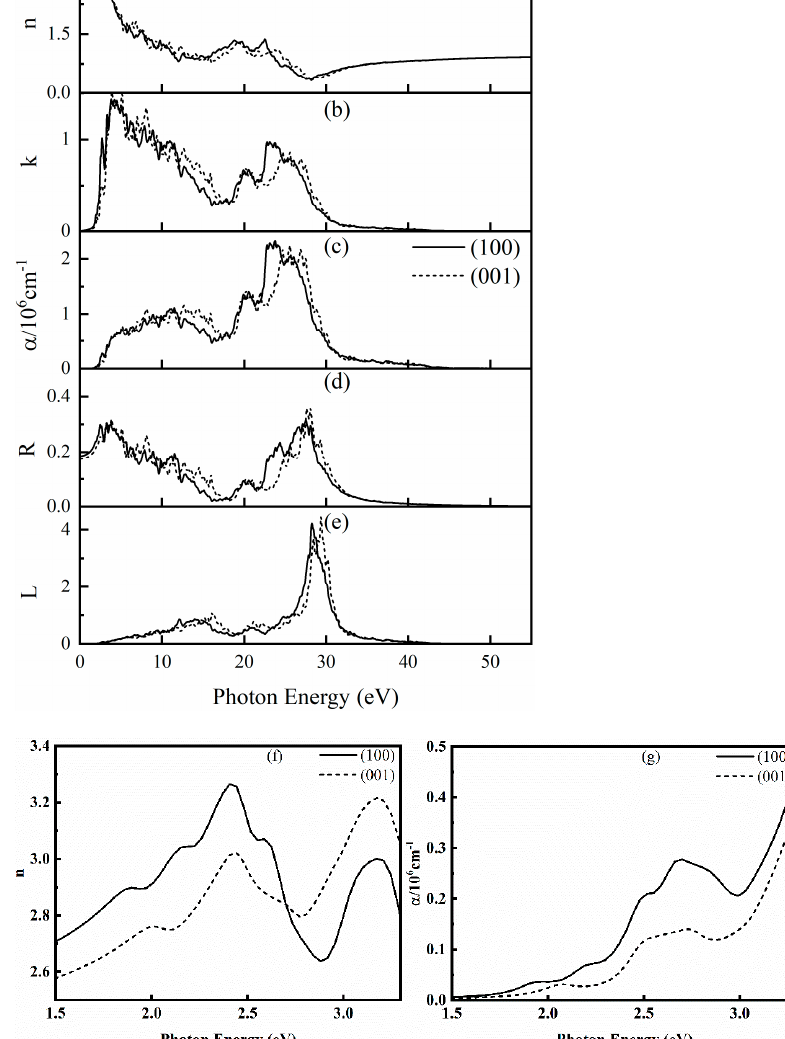
Figure 6. Calculated optical properties of SrCu 2 O 2 : ( a ) complex refractive index n , ( b ) extinction coefficient k , ( c ) absorption coefficient α , ( d ) reflection rate R , ( e ) energy loss spectrum L , ( f , g ) enlarged insets for the complex refractive index n and absorption coefficient α in the visible light region (1.5–3.3 eV), respectively.